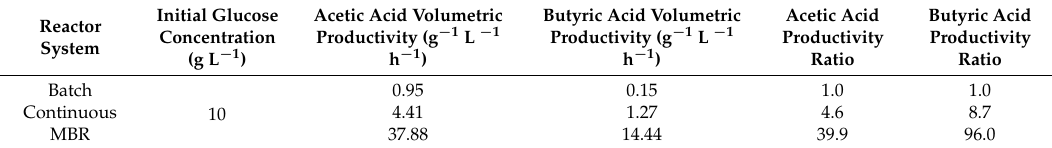
Table 5. Comparison of productivity of acetic and butyric acid in the batch, continuous and MBR systems